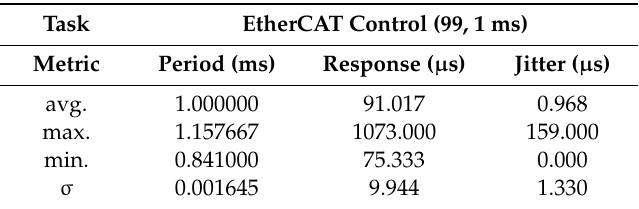
Figure 8. Comparison between the reference velocity and the encoder feedback: Span of ( a ) 60 s; ( b ) initial 5 s. Table 2. Real-time performance of the JECS-600ITX for an EtherCAT control